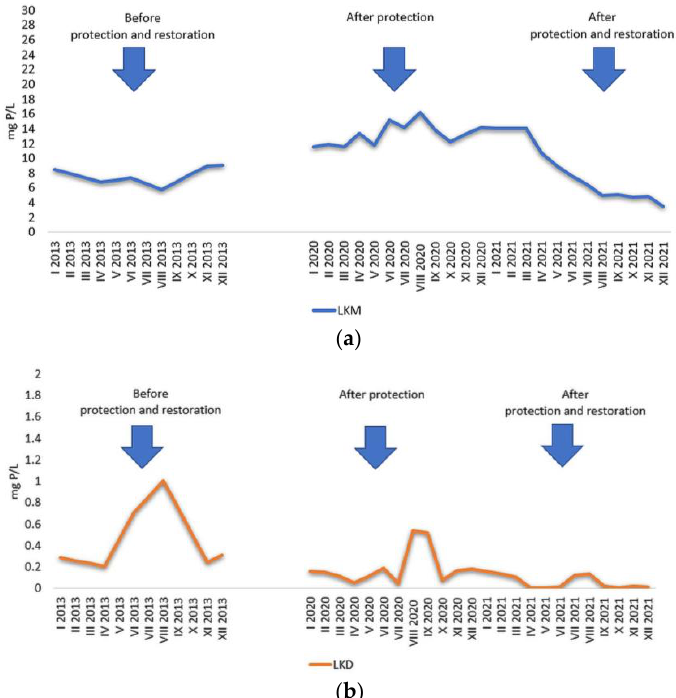
Figure 6. ( a ) Changes in the content of mineral phosphorus (P min .) in the bottom water layer of Lake Klasztorne Małe in selected research years. ( b ) Changes in the content of mineral phosphorus (P min .) in the bottom water layer of Lake Klasztorne Duże in selected research years.